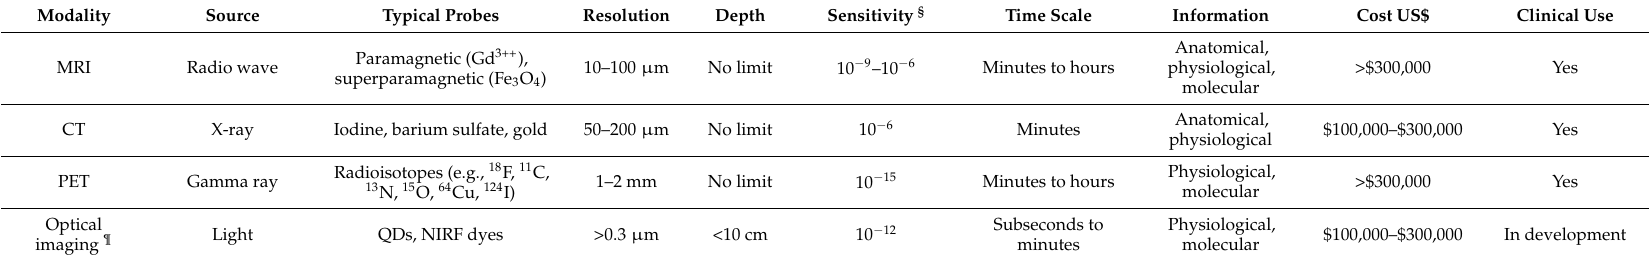
Table 1. Representative clinical and preclinical imaging modalities (Adapted with permission from [7]. Copyright 2014 DOVE Medical